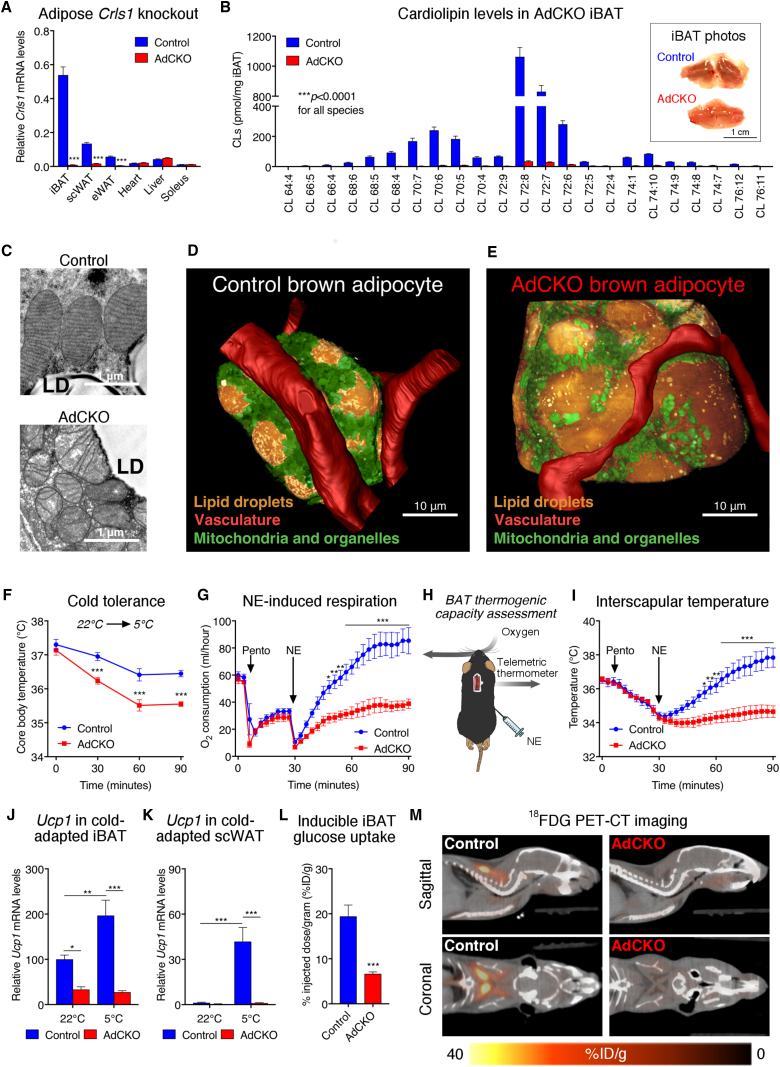
CRLS1 Is Critically Required for the Adipose Thermogenic Program(A) Crls1 mRNA levels in tissues from control and AdCKO mice (n = 6–7; t tests).(B) Liquid chromatography-mass spectrometry (LC-MS) based quantification of cardiolipin species from control and AdCKO iBAT (n = 6 per group, t tests) and photos of control and AdCKO iBAT (B; inset).(C) Representative transmission electron microscopy (TEM) images of control and AdCKO mitochondrial structure.(D and E) Three-dimensional reconstructions of a (D) control and (E) AdCKO adipocyte generated from dual-beam focused ion beam scanning electron microscopy stacks.(F) Rectal temperature of control and AdCKO mice subjected to a 22°C–4°C cold challenge for 1.5 hr (n = 8 per group; two-way ANOVA).(G–K) (G) Oxygen consumption, (H) schematic of BAT thermogenesis assessment, and (I) interscapular temperature from control and AdCKO mice following anesthetization and 1 mg/kg NE subcutaneous administration (n = 6 per group, two-way ANOVA). Ucp1 mRNA in (J) iBAT and (K) scWAT from control and AdCKO mice before and after 3 weeks of cold adaptation.(L and M) (L) Quantified mean glucose uptake and (M) representative images of 18F-fluorodeoxyglucose positron emission tomography/computed tomography (FDG-PET/CT) from control and AdCKO mice following intraperitoneal administration of CL-316,243. Data are presented as means ± SEM. ∗p < 0.05; ∗∗p < 0.01; ∗∗∗p < 0.001.See also Figures S4 and S5 and Videos S1, S2, S3, and S4.